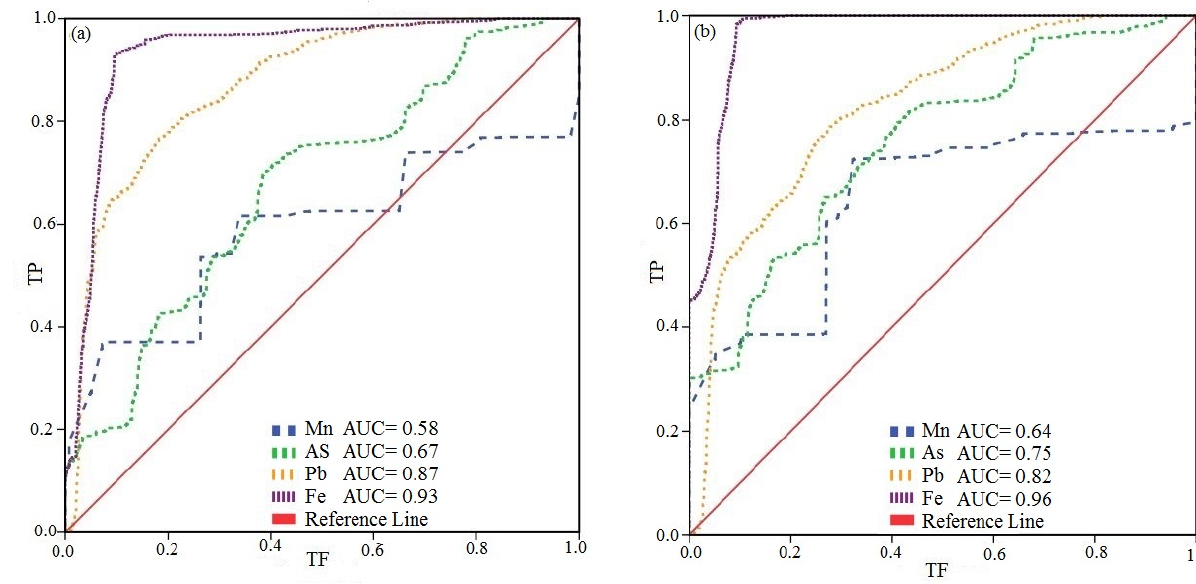
Figure 6. ROC/AUC for ( a ) GQI and ( b ) GWQI.